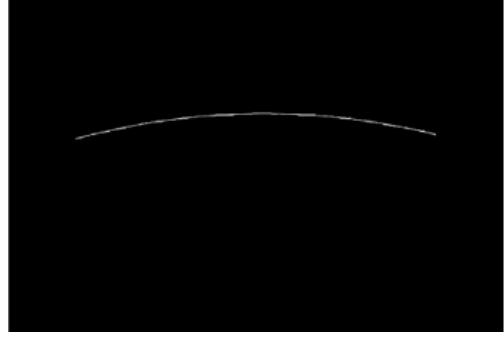
Figure 3. Distortion image at 90cm.